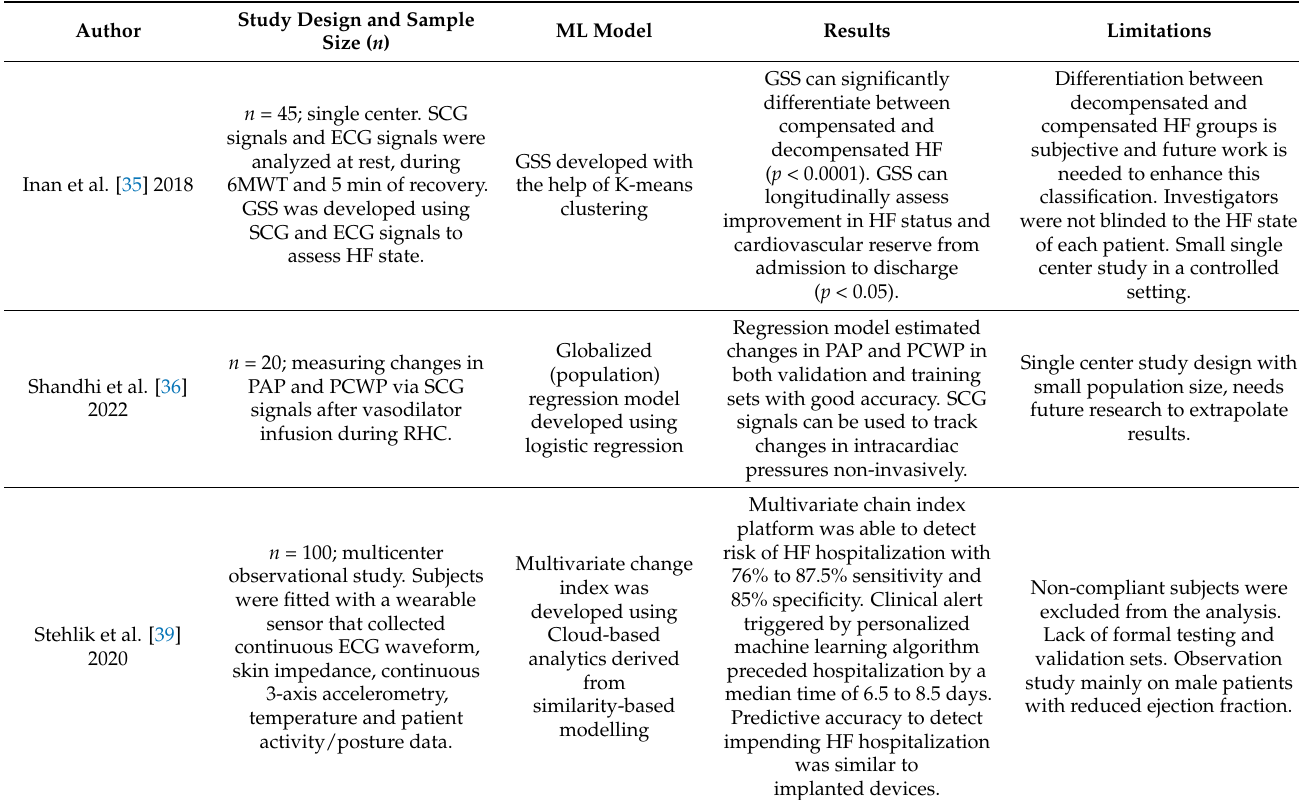
Table 2. Studies evaluating the use of ML models and wearable sensors in HF